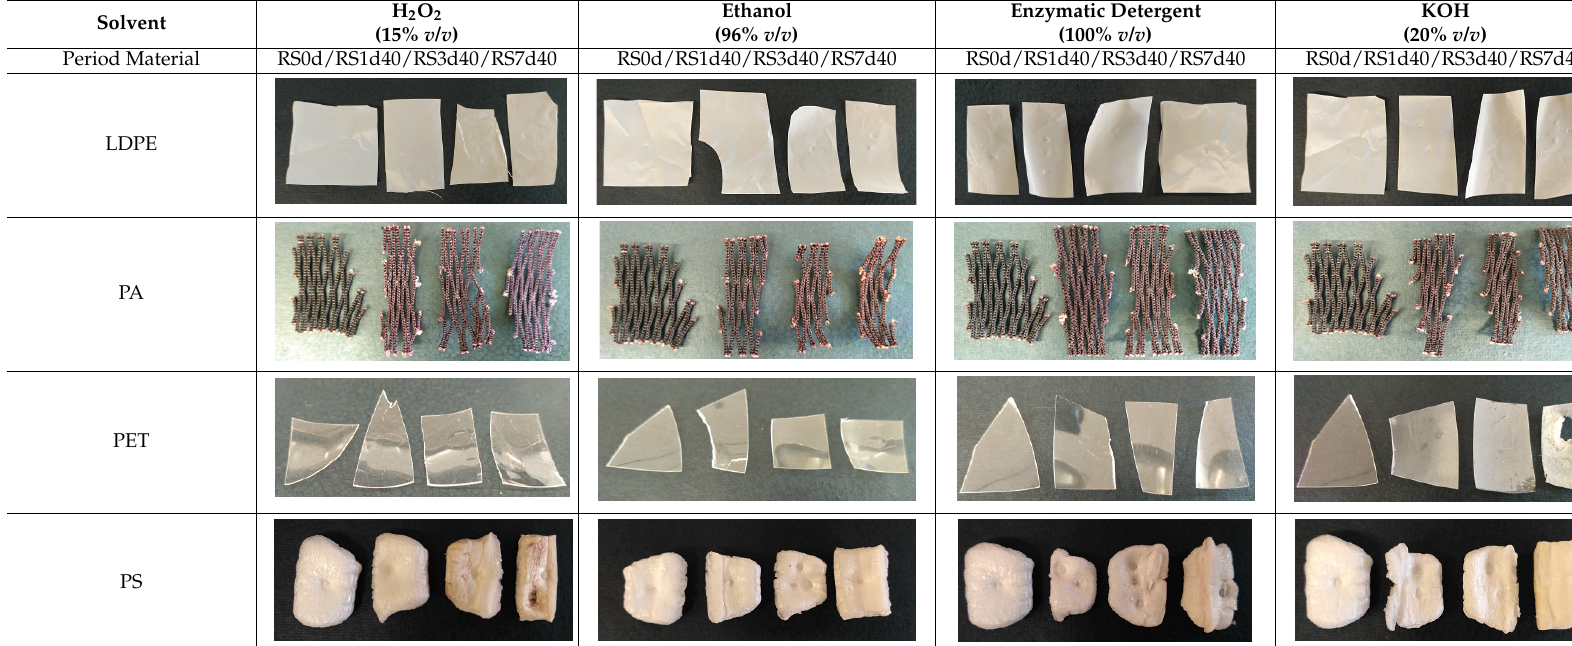
Table 2. Visual observation of reference samples (RS) during the test with different solvents. Samples are identified as RSXdY, where X and Y indicate the number of days and the treatment temperature, respectively.